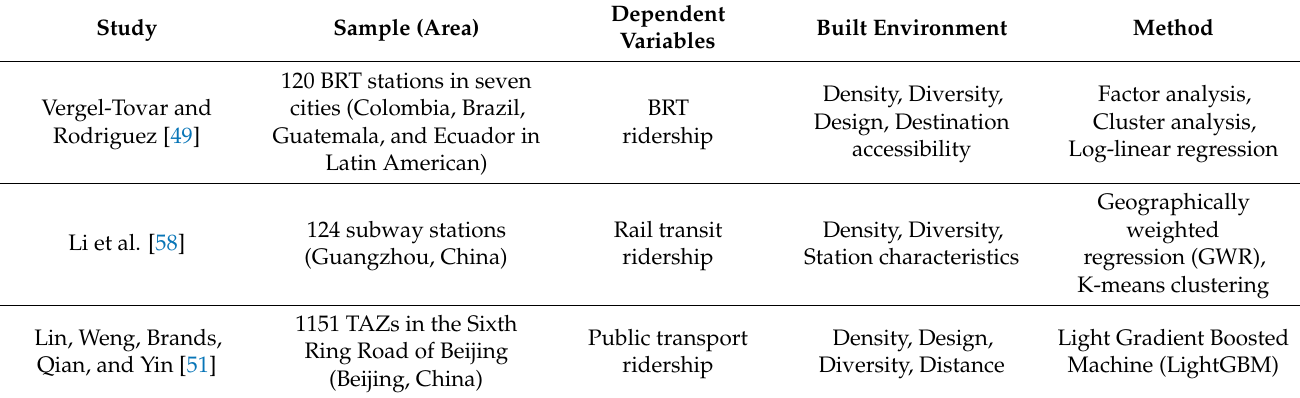
Table 1. Studies on the relationship between built environment and public